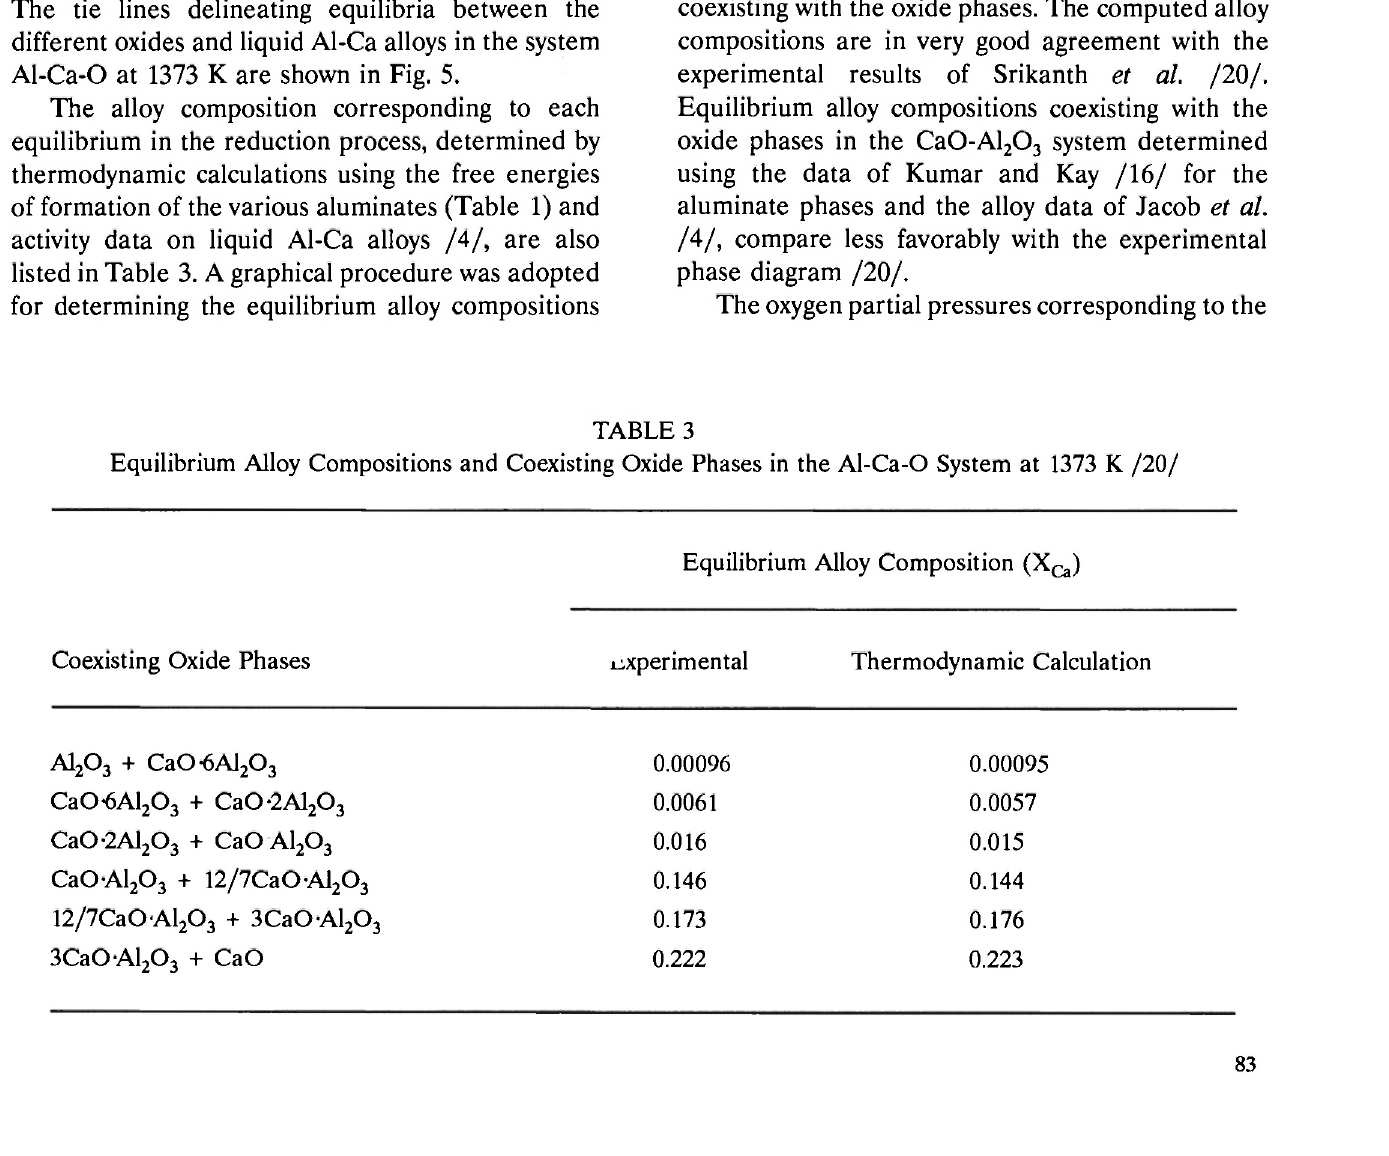
Fig. 5: Phase diagram of the AI-Ca-0 system showing the tie lines between the alloy and oxide phases at 1373 K.